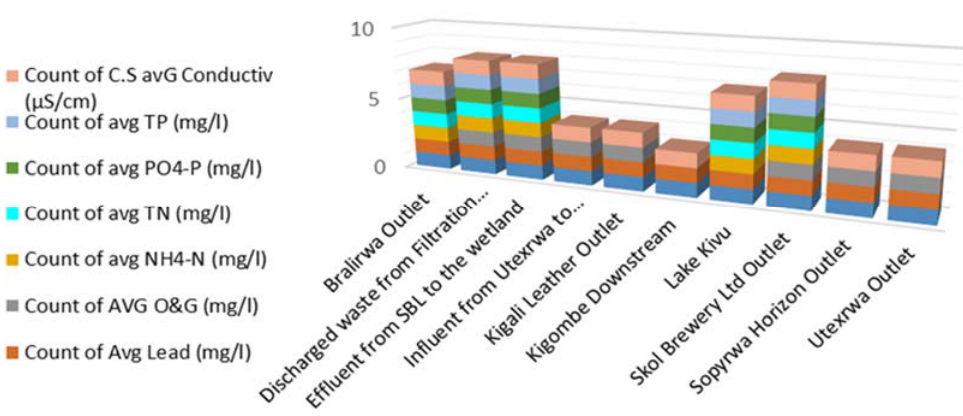
Figure 11. Distribution of various chemicals per site